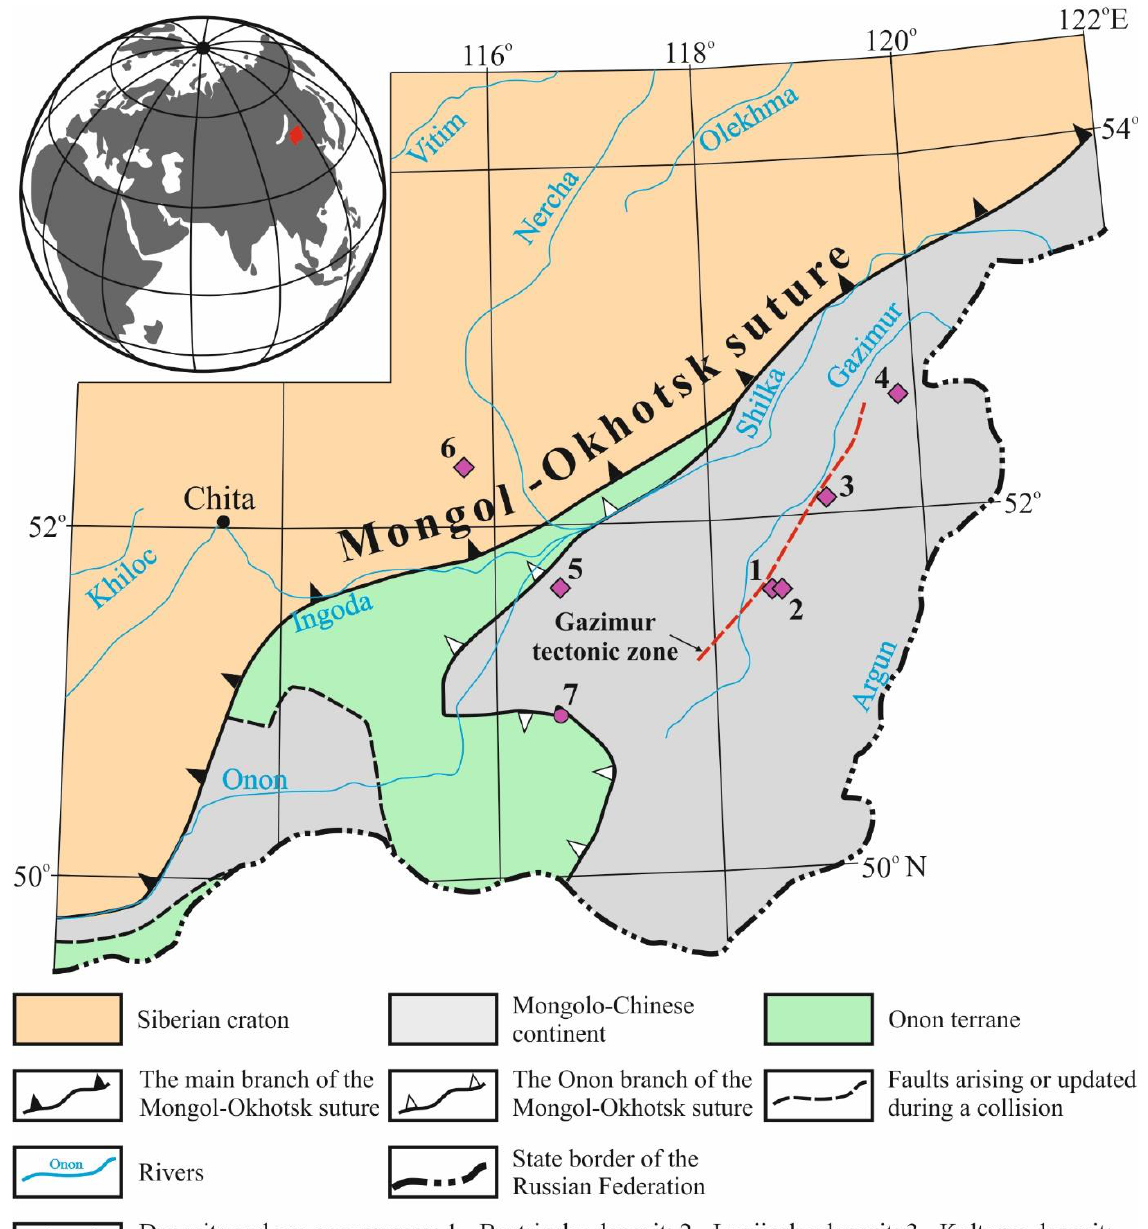
Figure 1. Regional tectonic map of the Eastern Transbaikalia (simplified from